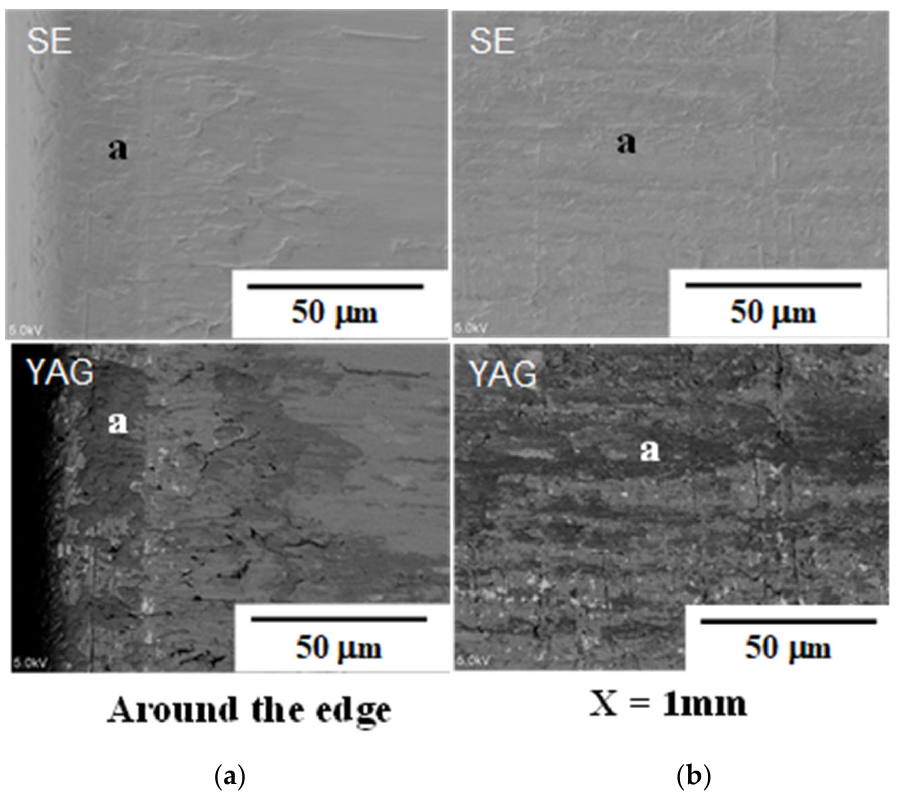
Figure 7. SEM and YAG images of the punch side surface with a higher magnification around the punch edge and at x = 1 mm from this edge: ( a ) SEM and YAG images around the punch edge and ( b ) SEM and YAG images at x = 1 mm from the punch edge.